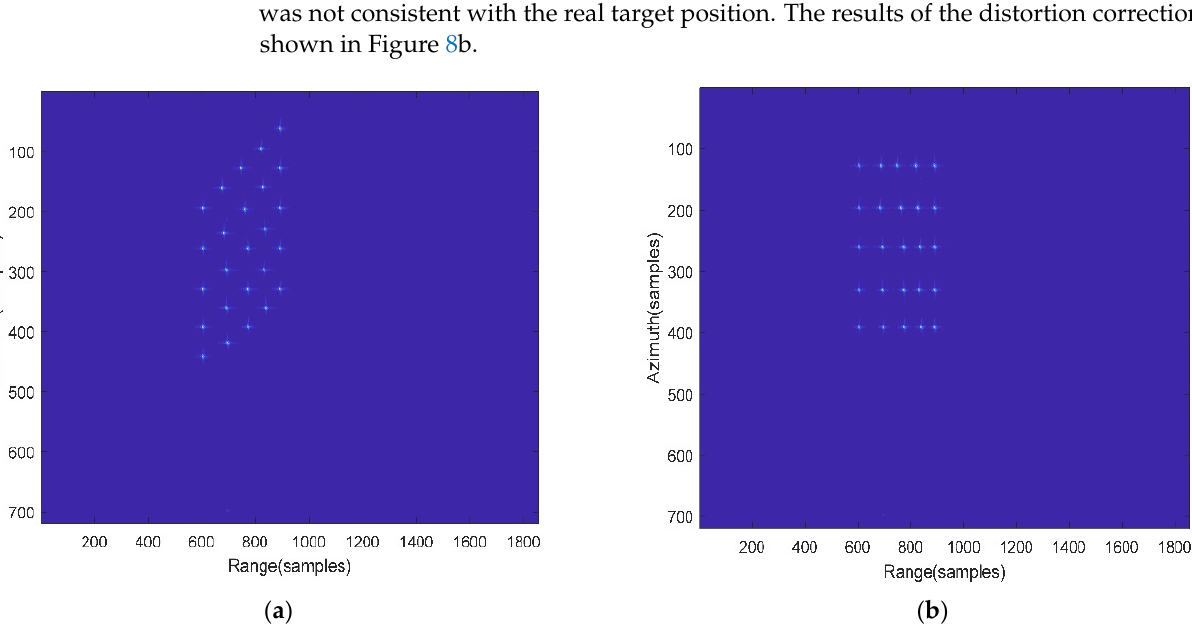
Figure 8. Final imaging results. ( a ) Before deformity correction; ( b ) after deformity correction.